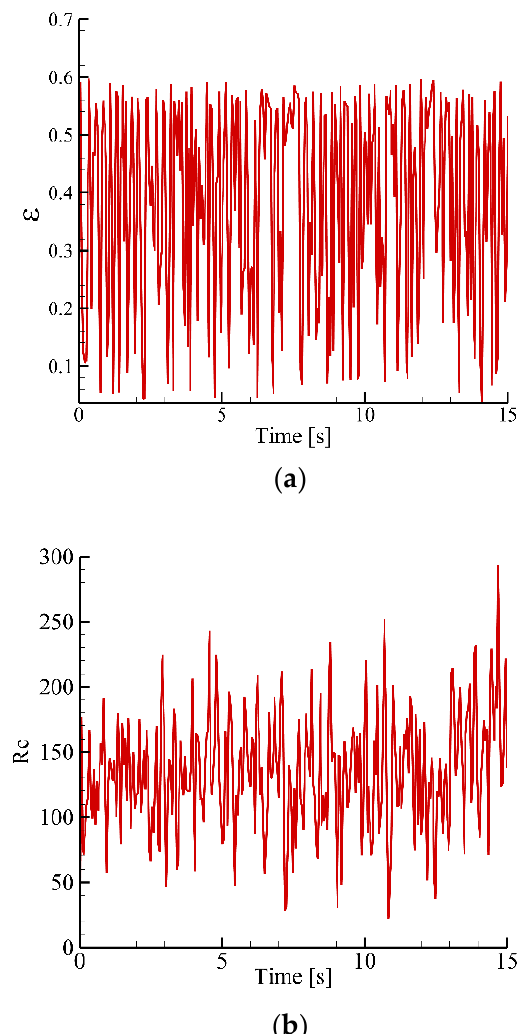
Figure 3. Variations in the local solid volume fraction ( a ) and mean particle Reynolds number ( b ) against flow time.